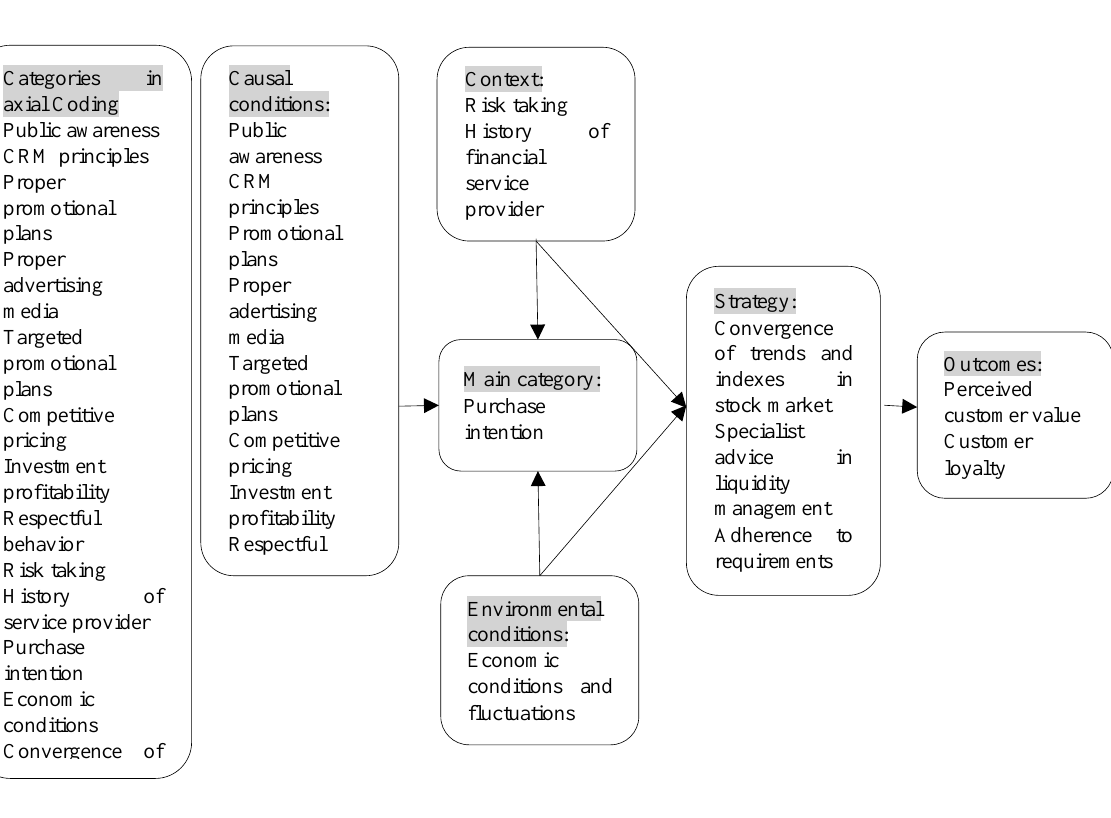
Figure 1.Conceptual